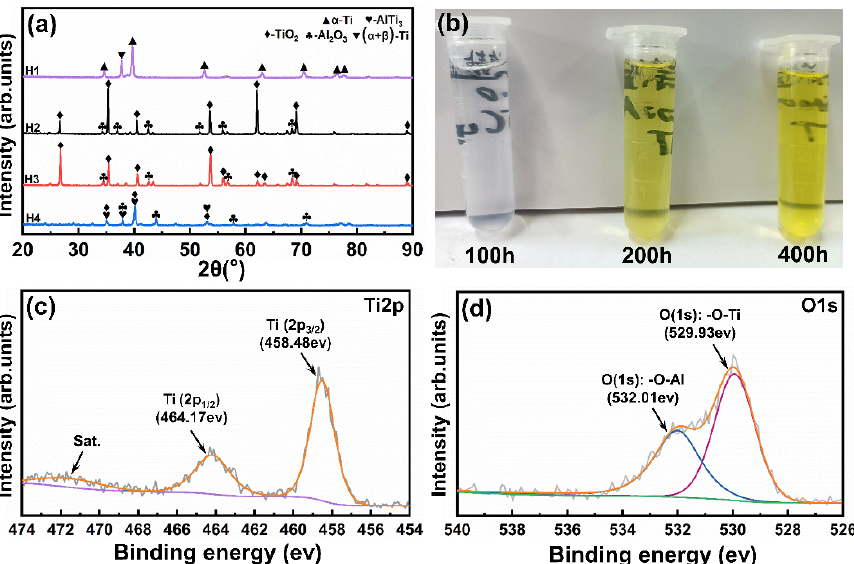
Figure 5. ( a ) XRD patterns of all tested samples; ( b ) color change of deionized water after washing of sample H4; ( c ) Ti2p spectrum of sample H1; and ( d ) O1s spectrum of sample H3.